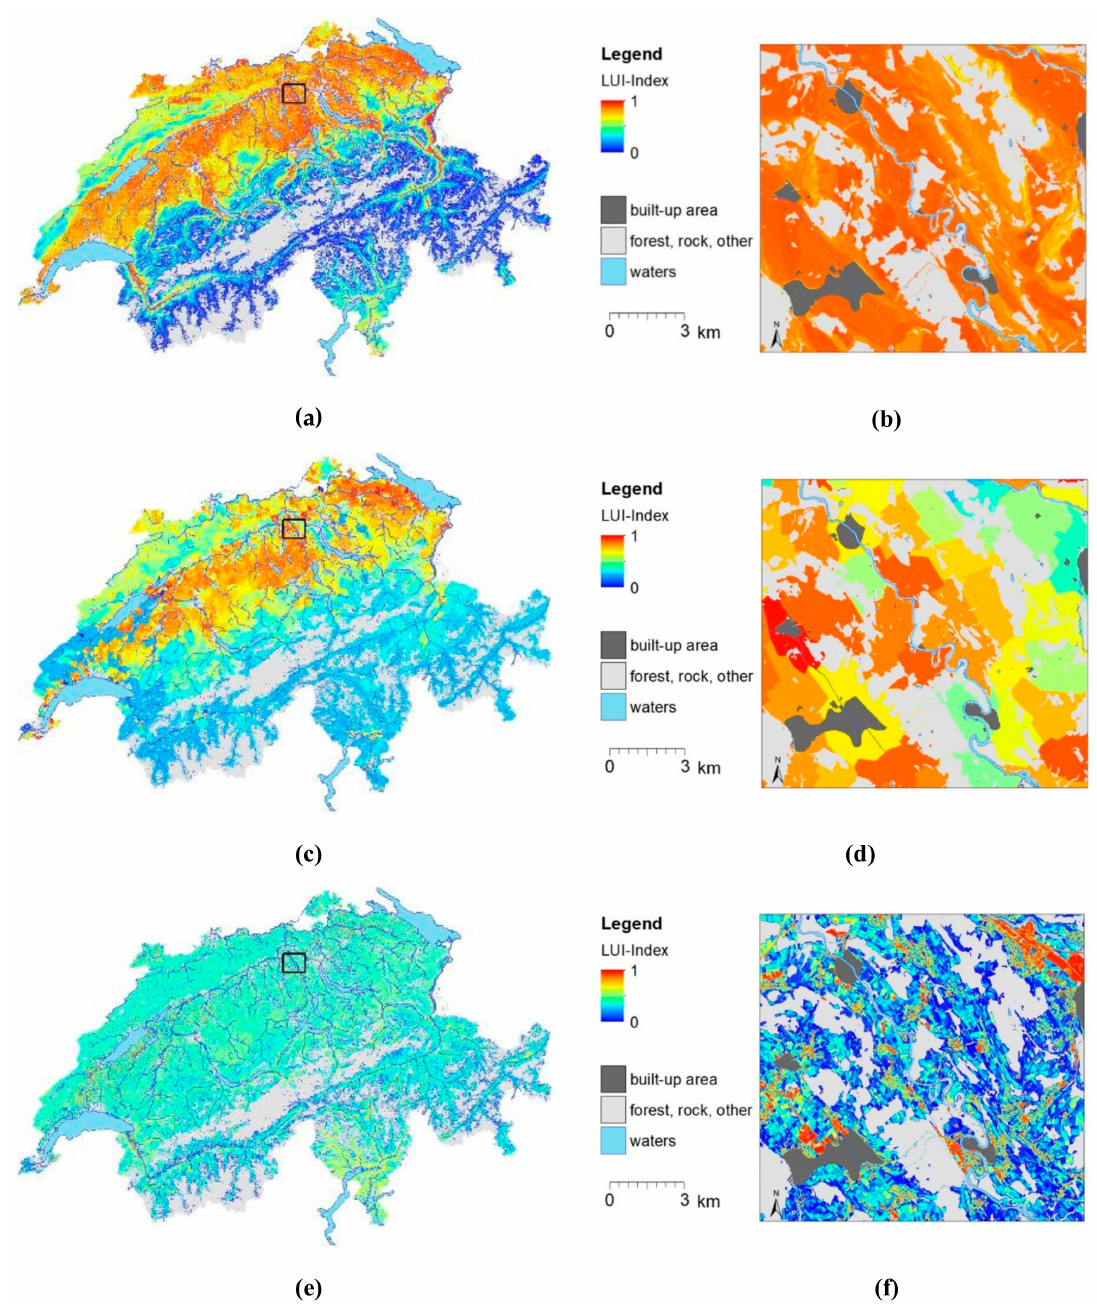
Figure 5. LUI map based only on ( a , b ) climate, topography, soil, ( c , d ) economy, and ( e , f ) remote-sensing data for Switzerland ( a , c , e ) and the excerpt from zoom level b from Figure 3 ( b , d , f